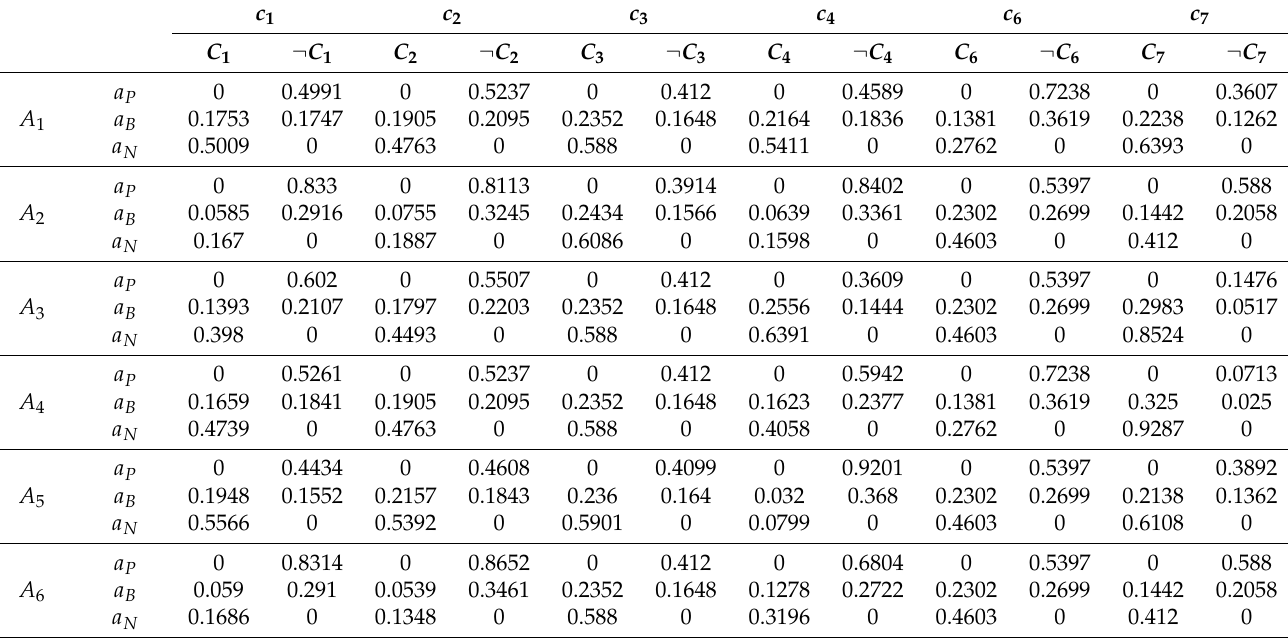
Table 10. The relative loss functions of Example 1.